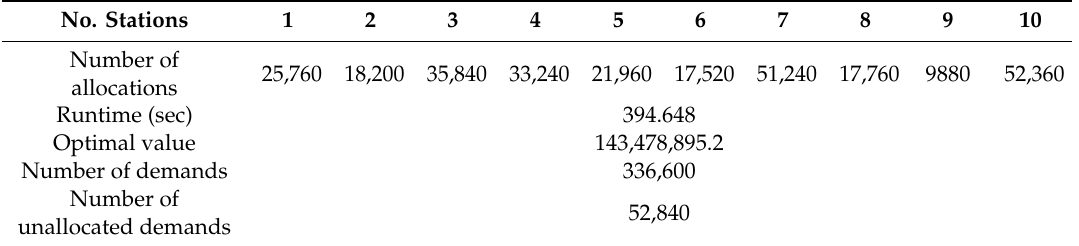
Figure 5. The allocation of each station using the Simulated Annealing algorithm. 4.1.3. Comparison of Algorithms and Validation of Models By comparing Tables 1 and 2, we see that both algorithms generate the same optimal value (the best result of Equation 1 is obtained from the iteration of each algorithm), as expected, because the